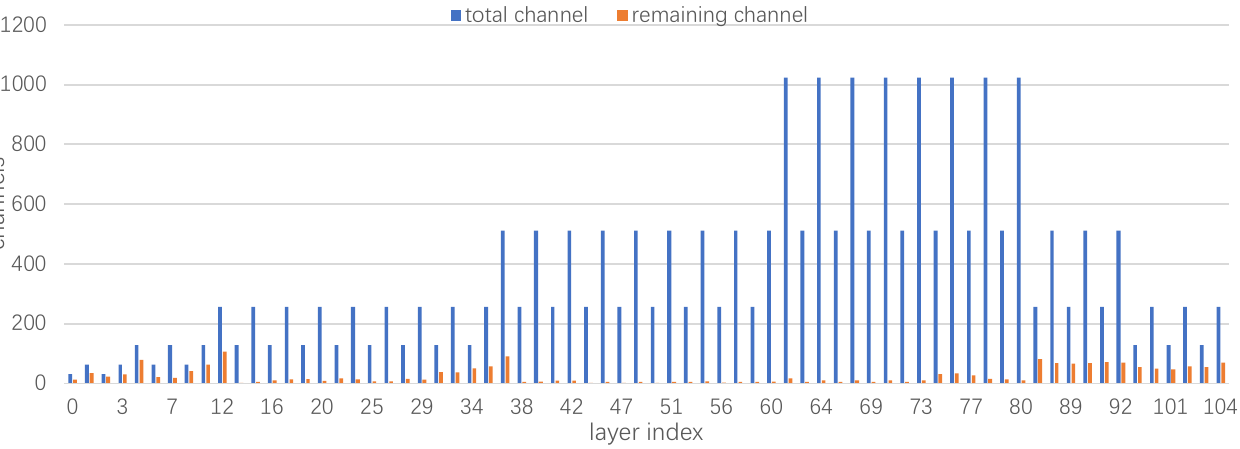
Figure 11. The changes of channels in each layer of the Yolov3 network prior to and after pruning.